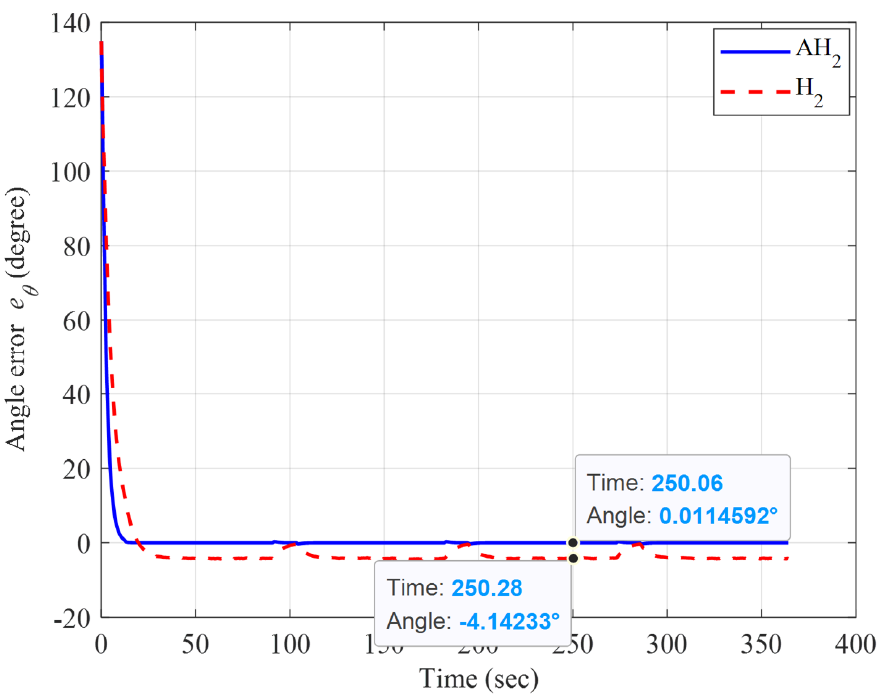
Figure 15. The square trajectory tracking error result of the adaptive H 2 closed-form and H 2 closed- form control approaches for Y from x p = 7 m, y p = − 7 m.